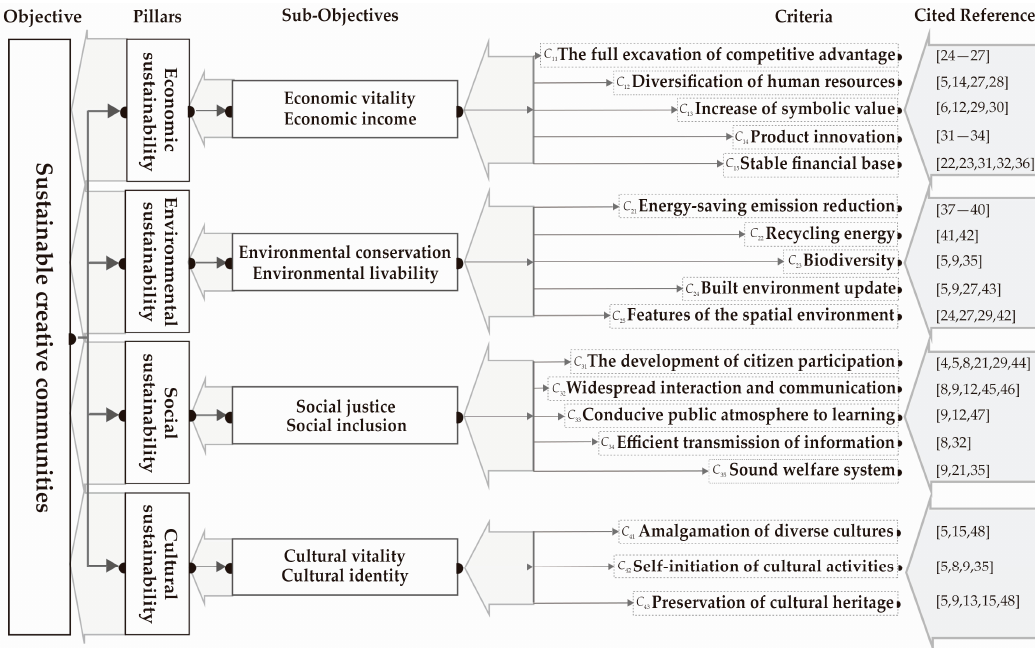
Figure 1 . Constructing an evaluation framework for sustainable creative communities. Figure 1. Constructing an evaluation framework for sustainable creative